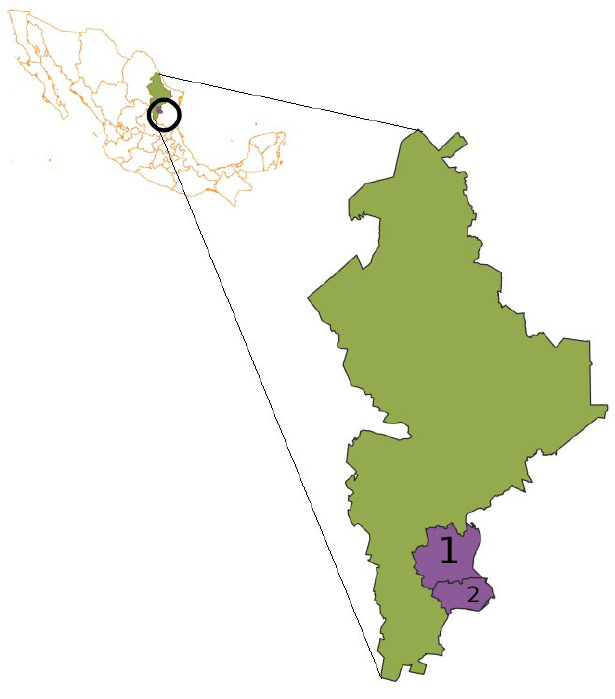
Fig. 3 . Location of the study site in Nuevo León state, Mexico showing the two municipalities in which the work has been